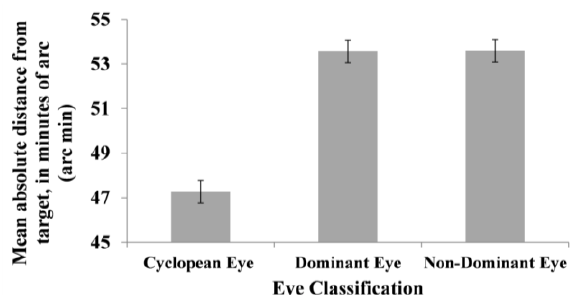
Figure 3: Mean absolute distance from target with cyclopean, dominant and non-dominant eyes. Error bars represent standard